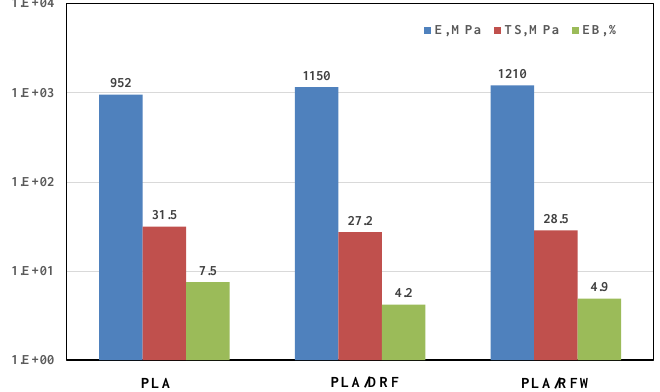
Figure 4. Main mechanical properties, i.e., elastic modulus, E; tensile strength, TS; and elongation at break, EB, of neat PLA and PLA containing 10%wt. of DRF and RFW.